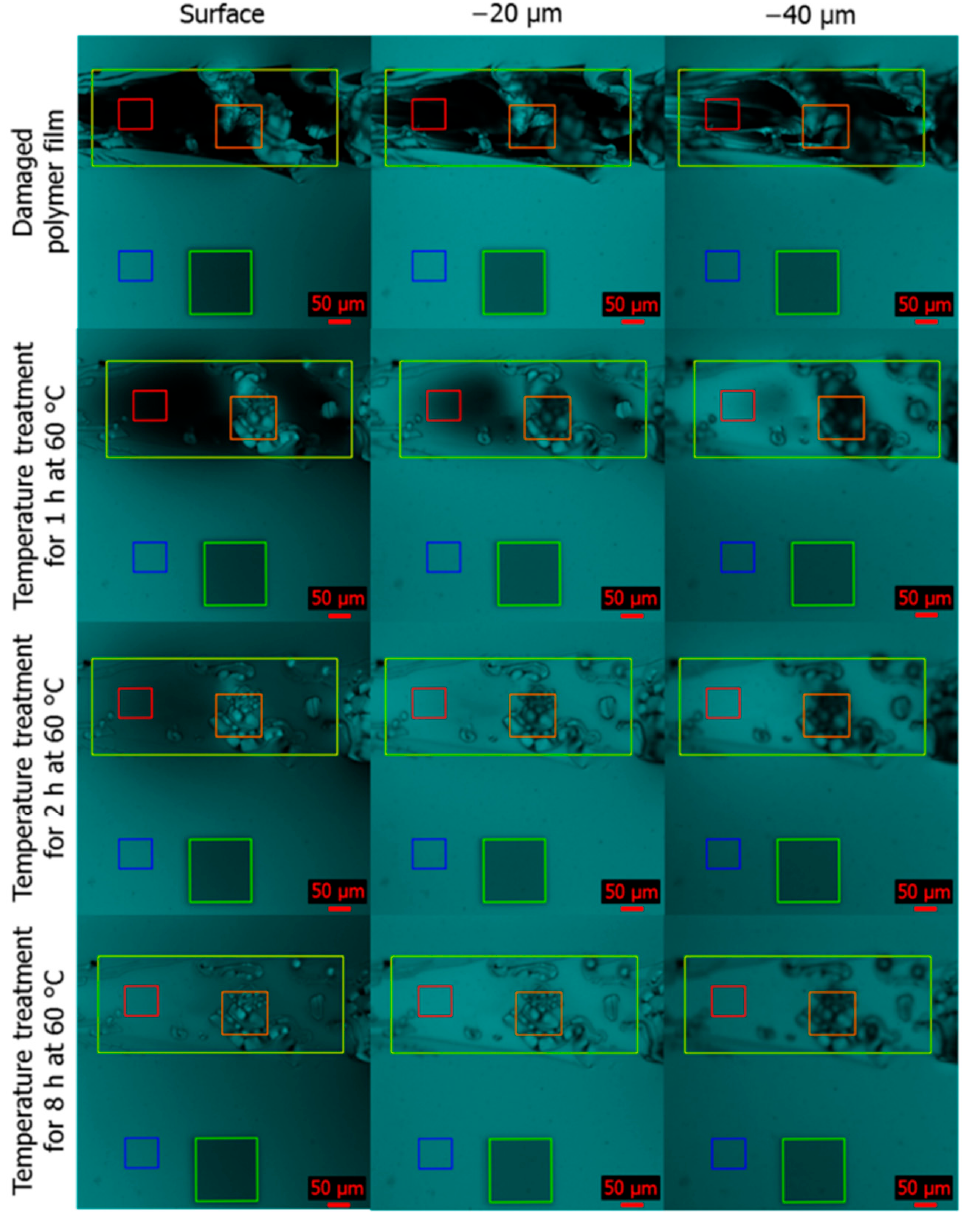
Figure 4. Time- and depth-dependent confocal laser scanning microscopy (CLSM) measurements in fluorescence mode ( λ ex = 405 nm) with the fluorescence channel ( λ em = 406 − 510 nm) monitoring thermally triggered self-healing procedure, in particular the virgin damaged cross-linked copolymer film, after 1, 2, and 8 h of thermal treatment at 60 °C: (red) homogeneous area within the scratch, (yellow) heterogeneous area covering the majority of the analyzed defect, (orange) specific area with residual removed film material, (blue) intact and undamaged reference area for each measurement, and (green) photo-bleached marker area. Reprinted with permission from [29]. Copyright 2018 American Chemical Society.